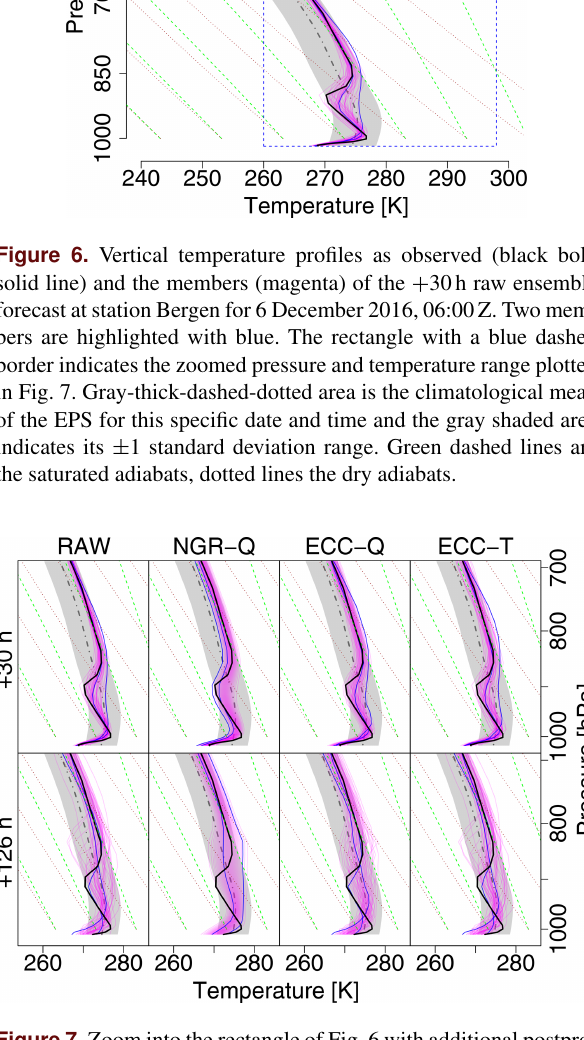
Figure 7. Zoom into the rectangle of Fig. 6 with additional postpro- cessed temperature profiles. The columns show (from left to right) raw ensemble; univariate postprocessing with NGRVC; and multi- variate postprocessing with ensemble copula coupling (ECC) of the NGRVC-postprocessed ensemble using quantile sampling (ECC-Q) and distance-preserving sampling (ECC-T), respectively. All figures additionally have observation (bold black), climatological observa- tion (mean (dashed gray) and standard deviation (gray)), and two particular forecast members. The first row contains the forecasts for lead time + 30h, the second row for +